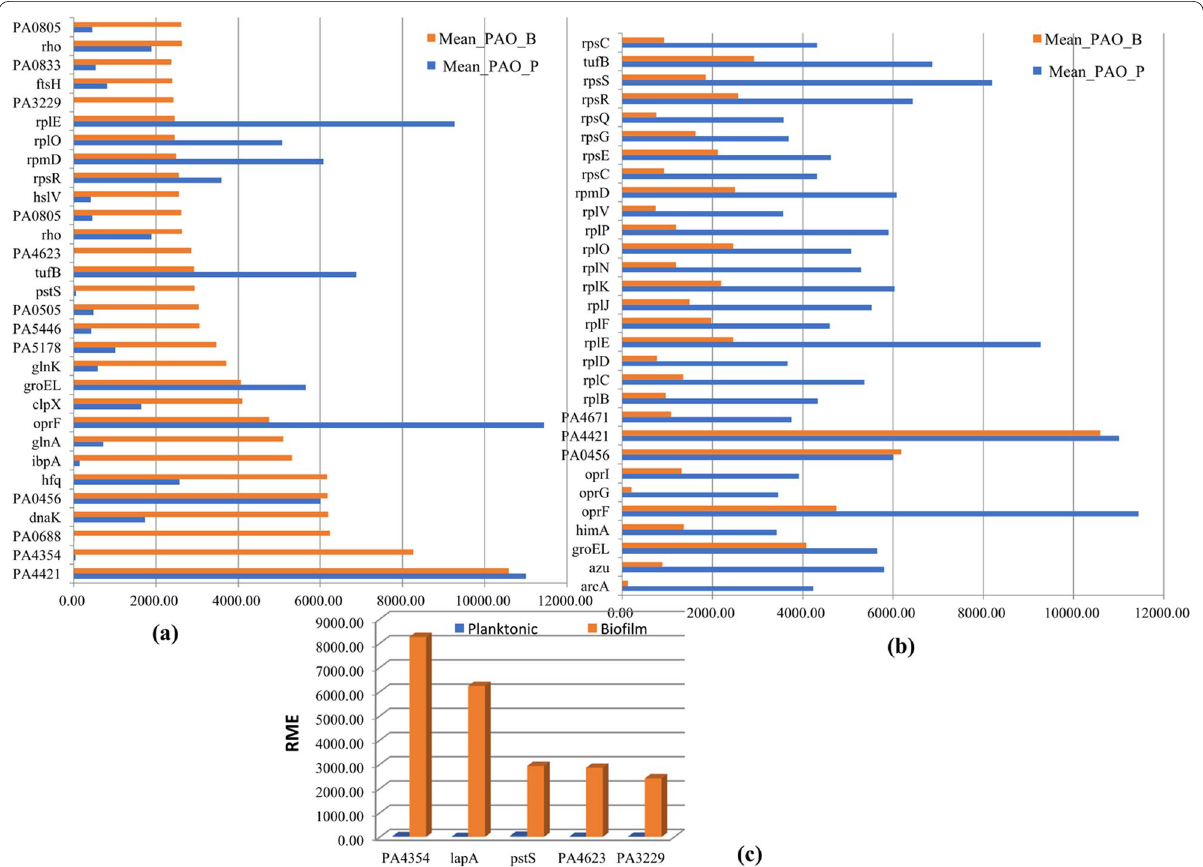
Fig. 3 Relative mean expression (RME) levels of genes in biofilms and planktonic cells. RME values were calculated from the average values of normalized read counts in the biofilms (n 3) and planktonic (n 3) samples. a The 30 highest RME values were sorted in ascending order for = = genes in biofilm samples and are displayed with the RME values of corresponding genes in planktonic samples; b The 30 highest RME values were sorted in ascending order for genes in planktonic samples and are displayed with the RME values of corresponding genes in biofilm samples. c Genes highly expressed in biofilms but extremely low expression in planktonic